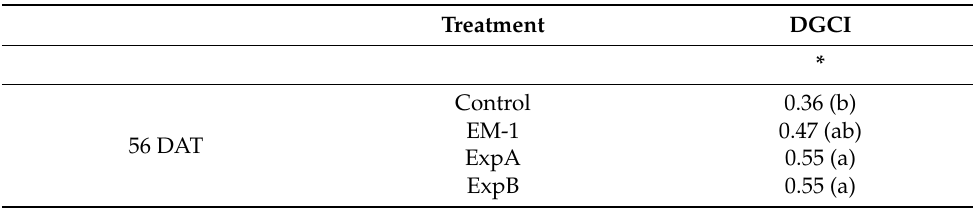
Table 3. Dark green colour index (DGCI) of creeping bentgrass at 56 DAT in response to exposure to the untreated control, EM-1, ExpA and ExpB.